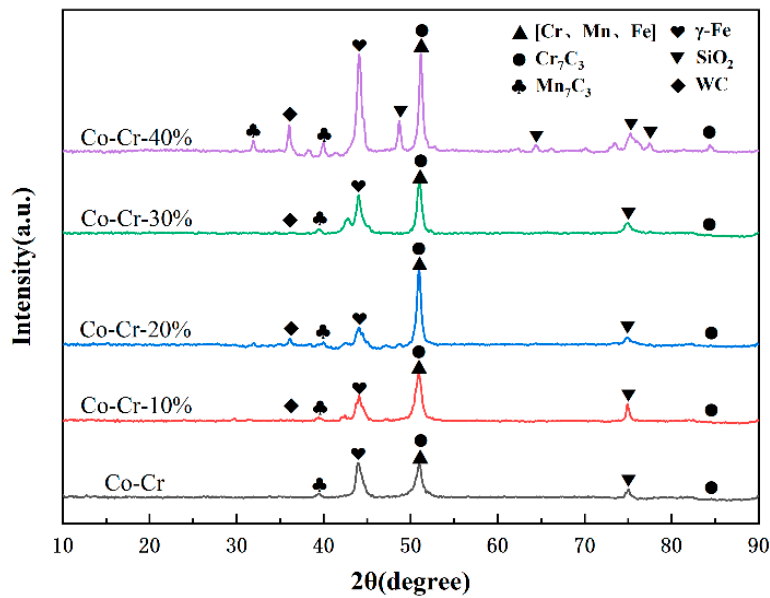
Figure 2. XRD pattern of Co-Cr composite cladding